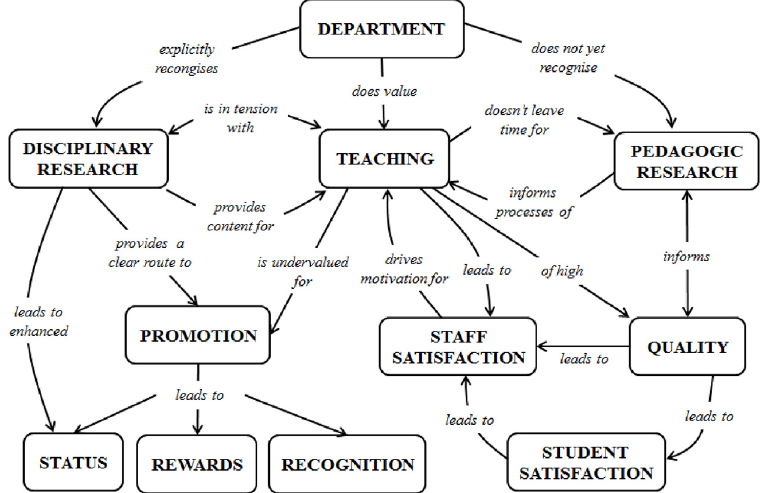
concept map of the group ’ s perspective of the